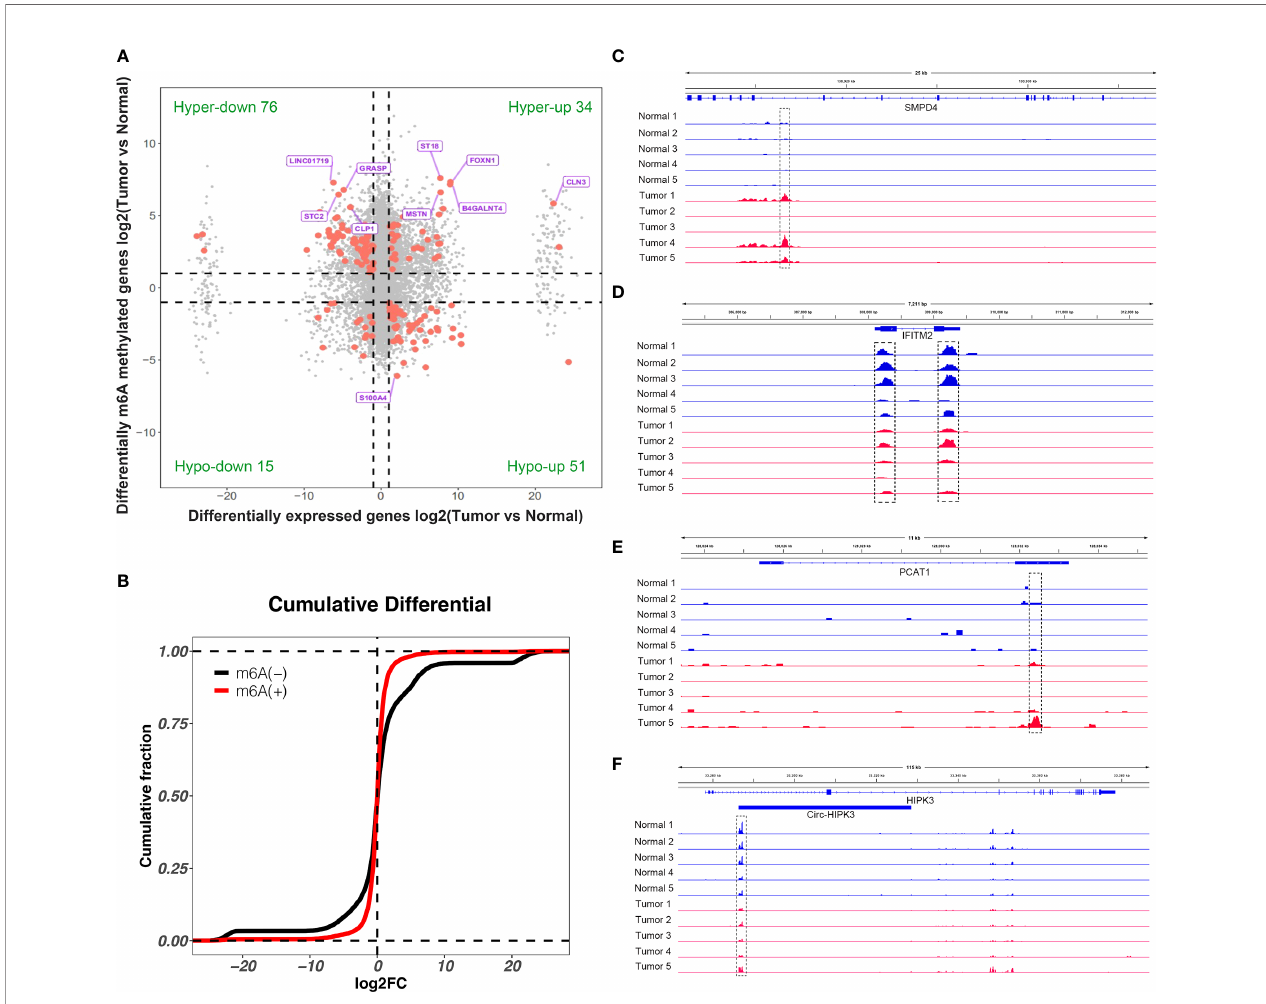
FIGURE 5 | Conjoint analysis of differentially methylated genes and differentially expressed genes. (A) Four-quadrant diagram showed the differentially methylated genes and differentially expressed genes in tumor and adjacent normal tissues. (B) Cumulative distribution of gene expression between tumor and adjacent normal tissues for m 6 A transcripts (red) and non-m6A transcripts (black). (C – F) Integrative Genome Viewer (IGV) software showed representative differentially methylated mRNAs (SMPD4 and IFITM2), lncRNA (PCAT1), and circRNA (circ-HIPK3) in tumor and adjacent normal